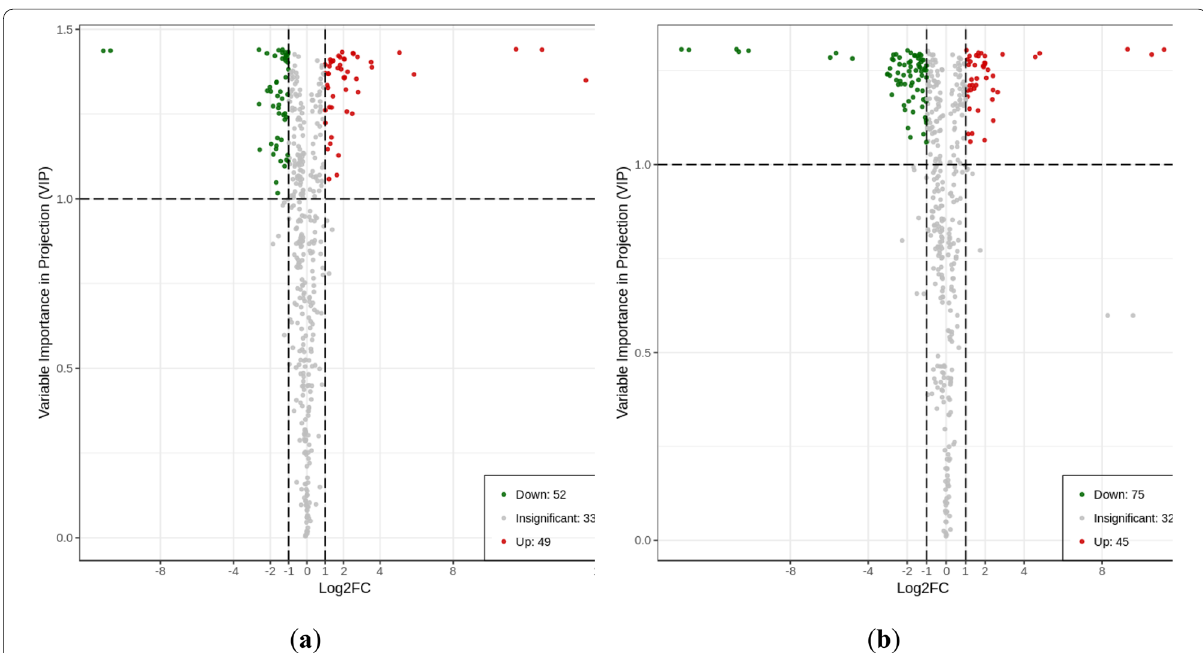
Fig. 5 Volcano maps of differential metabolites between the following pairs of groups: a HN44-CK vs. HN44-DS; b HN65-CK vs. HN65-DS. Each volcanic map point represents a metabolite; Abscissa, compare the logarithm of the number fold change of metabolites in the sample; Ordinate, VIP value. Increased abscissa absolute values indicate increased differences in expression multiples between the two samples, and increased ordinate values indicate increased significance in differential expression; metabolites with more reliable differential expression were